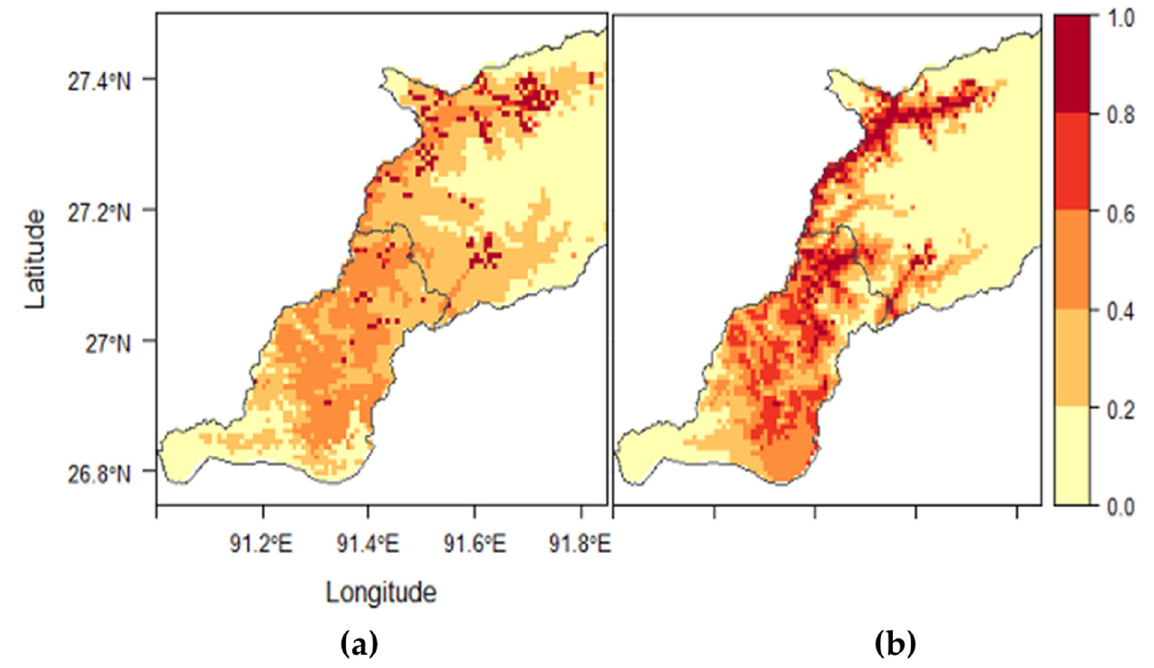
Figure 6. Habitat suitability maps developed by the best models ( a ) for Haemaphysalis bispinosa using LULC, Bio 18, and Bio 16 and ( b ) for Haemaphysalis spinigera using LULC, Bio 19, and Bio 16.